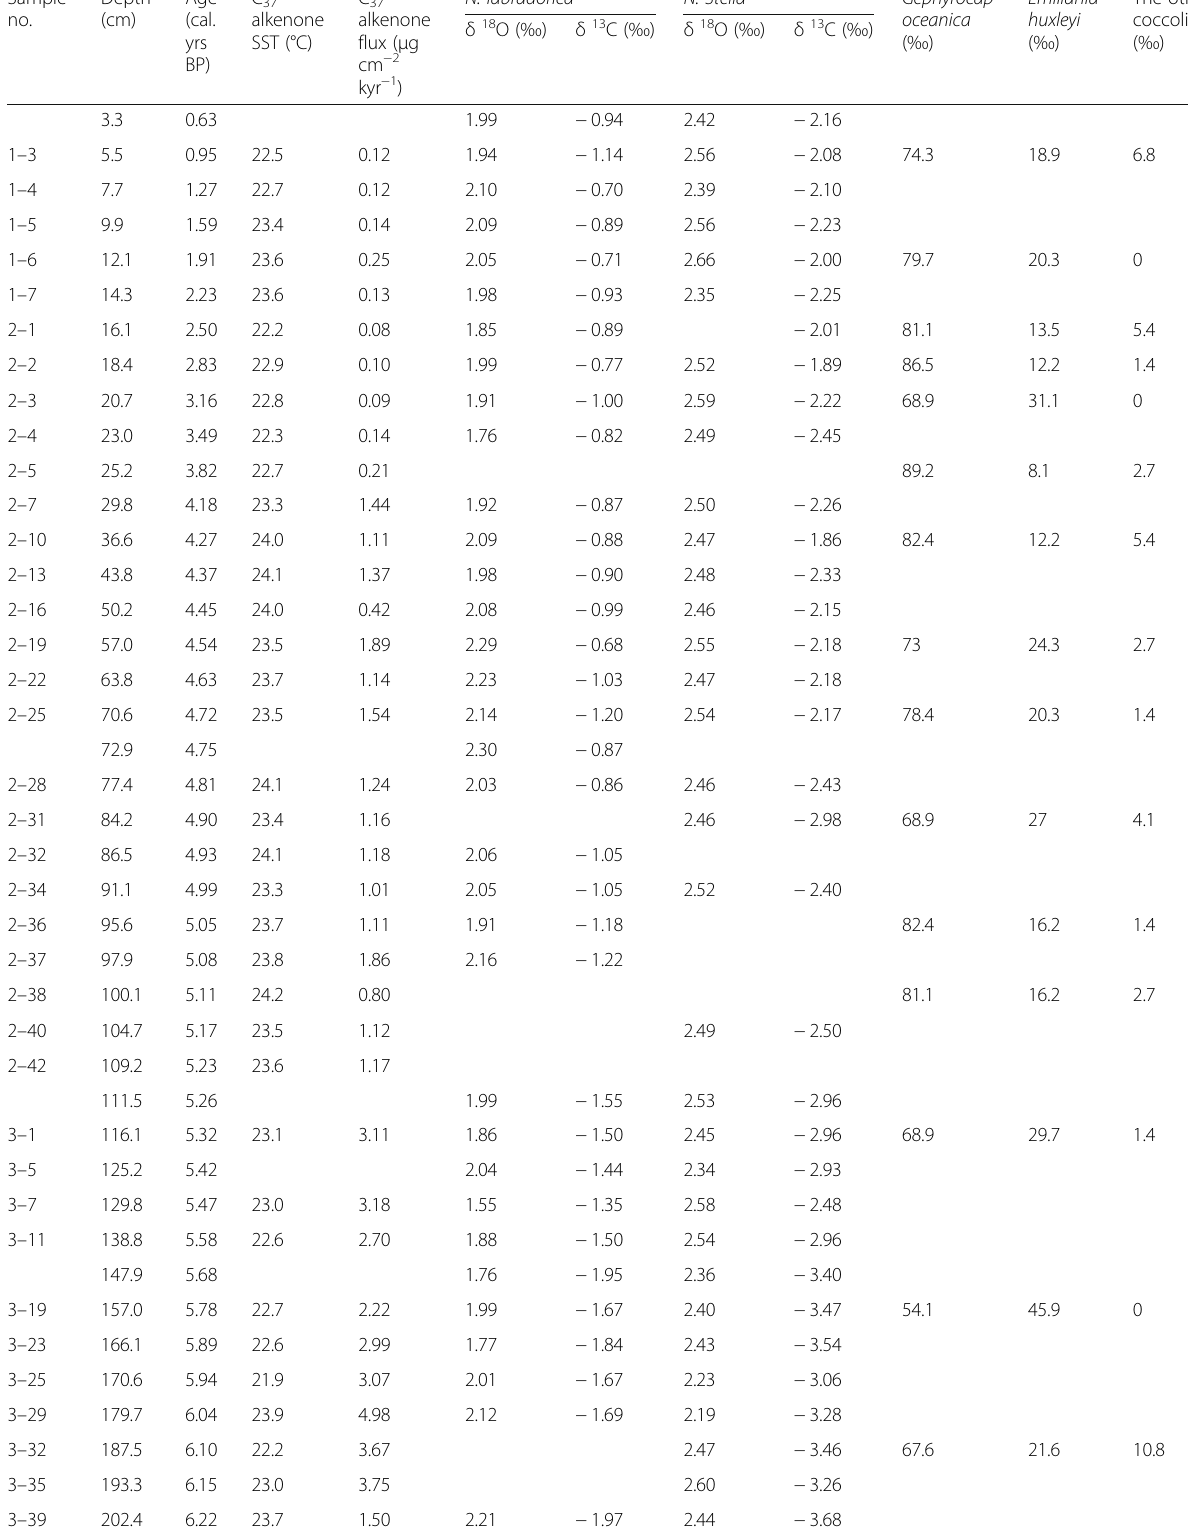
Table 2 Sampled core depths; ages; sea surface temperatures (SST); fluxes of C37 benthic foraminifera; relative abundance of pollens including Castanea , Abies , and Picea ; and relative abundance of coccoliths Sample